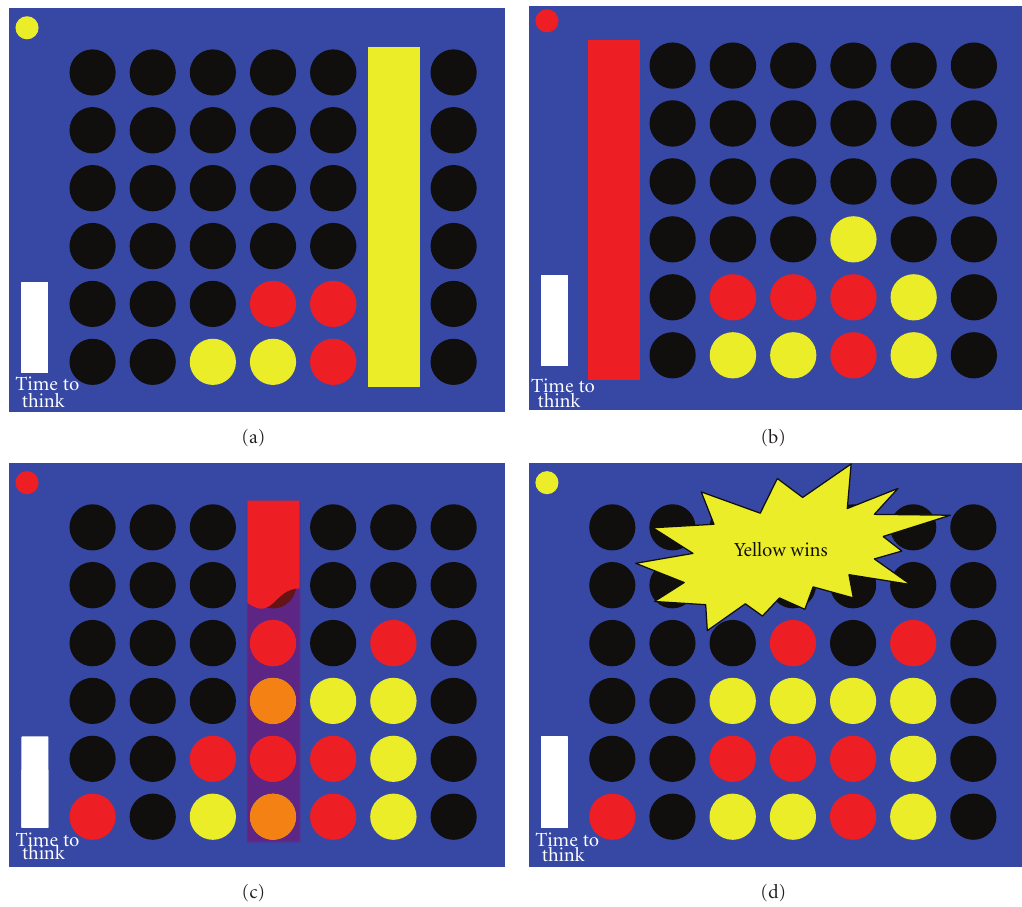
Figure 5: Third game in classic mode. Yellow won by connecting four coins horizontally. For the purpose of illustration, the red rectangle was made partially transparent to make all coins visible.